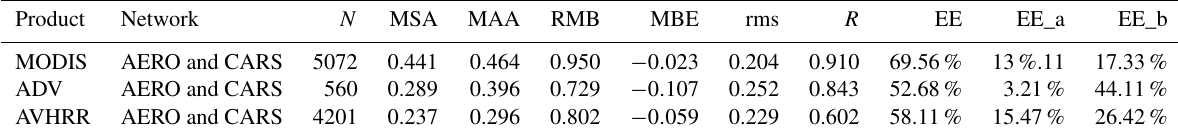
Figure 4. AOD time series for MODIS (a) and (A)ATSR and AVHRR (b) , with AERONET AOD (blue) as reference, over the Beijing site for the years 2000–2012. For (A)ATSR seasonally averaged AOD is plotted. For AVHRR and MODIS the AOD data are monthly averages. Table 2. Metrics obtained from the evaluation of three AOD products. N is the number of co-located data points, MSA is mean satellite- retrieved AOD, MAA is mean sun-photometer-retrieved (AERONET and CARSNET) AOD and RMB is the ratio of MAA to MSA. MBE is mean of AOD bias given by τ sat − τ aero . R is the Pearson correlation coefficient, and rms is the root mean square. EE is the expected error, EE_a is the fraction above the EE and EE_b is the fraction below the